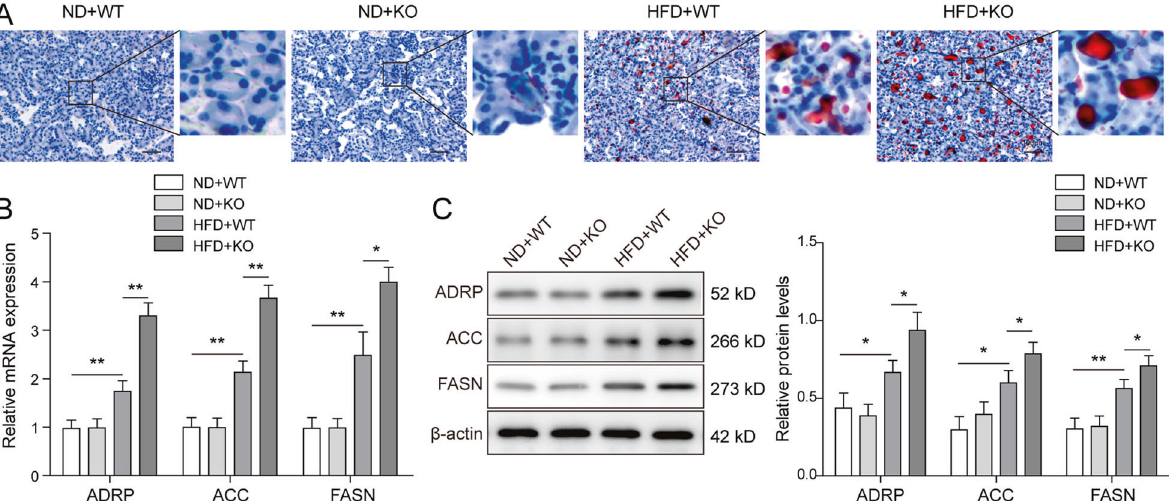
Fig. 2 ACE2 de fi ciency induced excess fat deposition in ORG-mouse kidney tissues. A Lipid deposition in renal tissues was assessed by Oil Red O staining and HFD + ACE2-KO mice accumulated most fat. B qRT-PCR assay was performed to detect the relative mRNA expression of adipogenesis-related proteins. Highest expression of ADRP, ACC, and FASN was observed in HFD + ACE2-KO mice, followed by HFD + WT, ND + ACE2-KO and ND + WT mice. C The protein expression of the adipogenesis-related proteins was examined by western blot. Data were representative images or were expressed as the mean ± SD of n = 3 experiments. * P < 0.05, ** P <